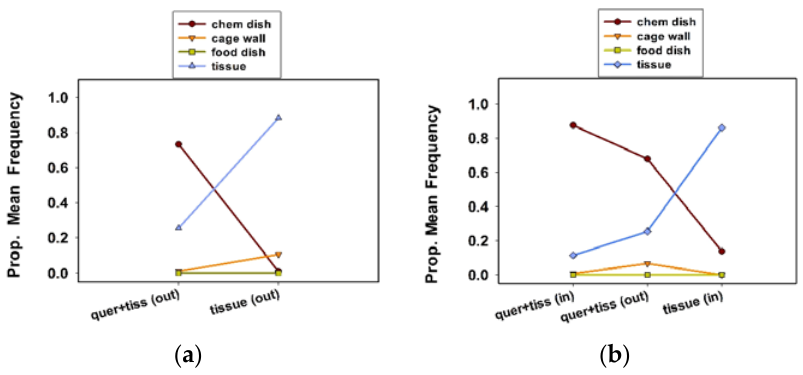
Figure 4. Proportional mean frequency of C . maculata egg clutches at sites in response to treatments in communal cages in experiment 4 ( a ), and experiment 5 ( b ).